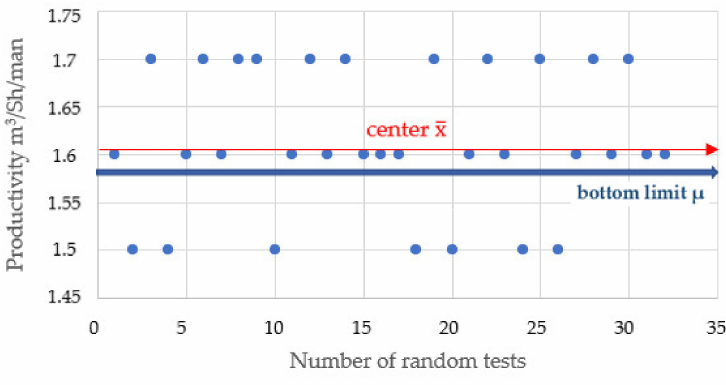
Figure 9. Graphic illustration of masonry performances including the mean value.